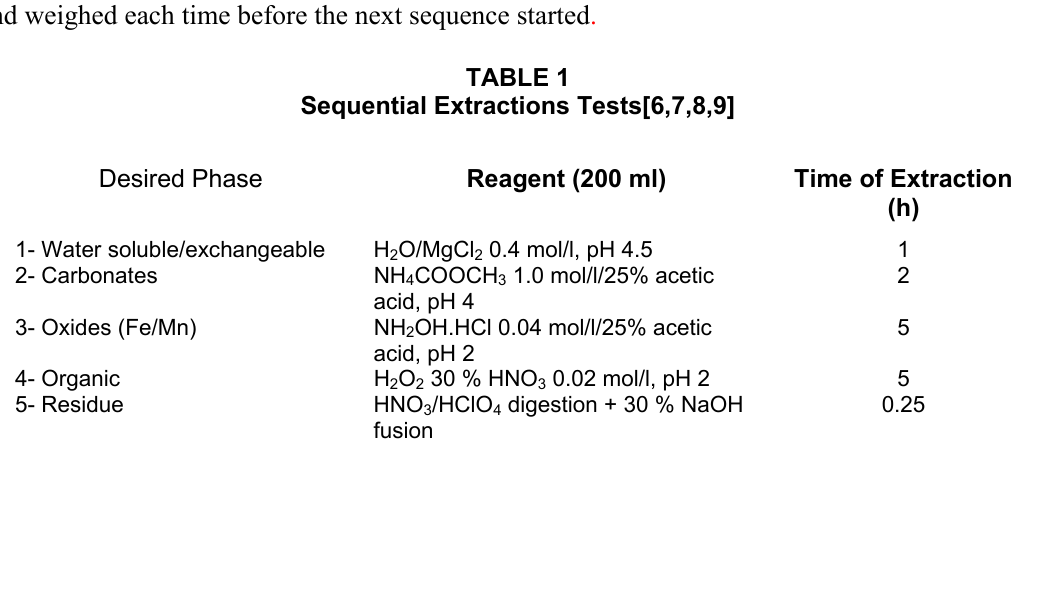
Sequential Extractions